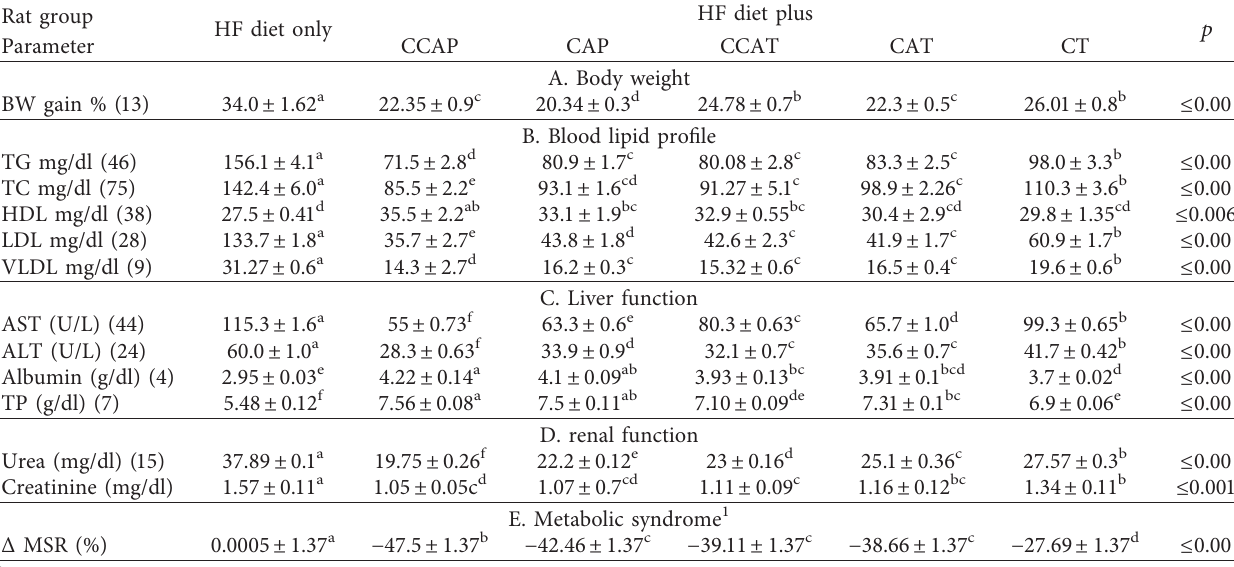
Table 4: Effect of various fermented types of milk on body weight, blood lipid profile, serum proteins, liver enzymes, and kidney markers in overweight, hypercholesterolemic-made rats on a high-fat, high-cholesterol